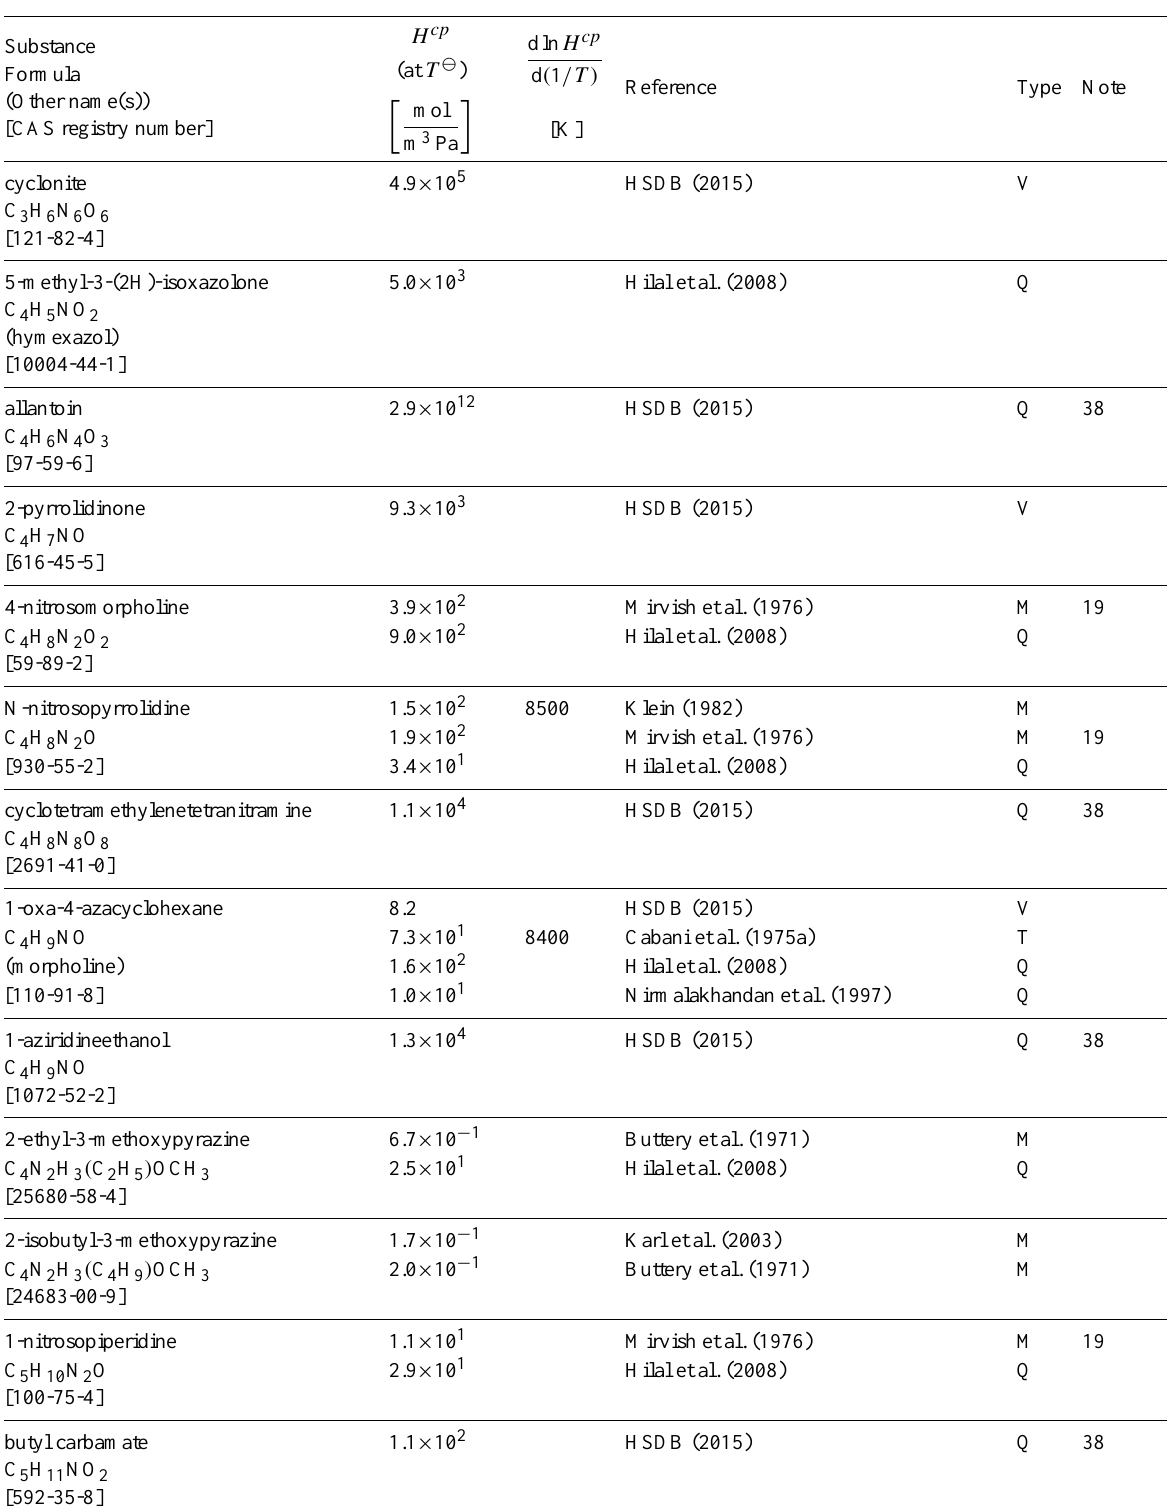
Table 6: Henry’s law constants for water as solvent